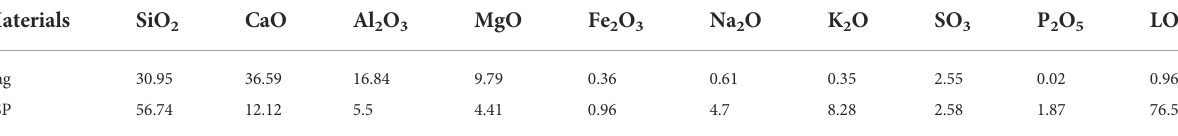
TABLE 1 Chemical composition of slag and RSP (wt. %).